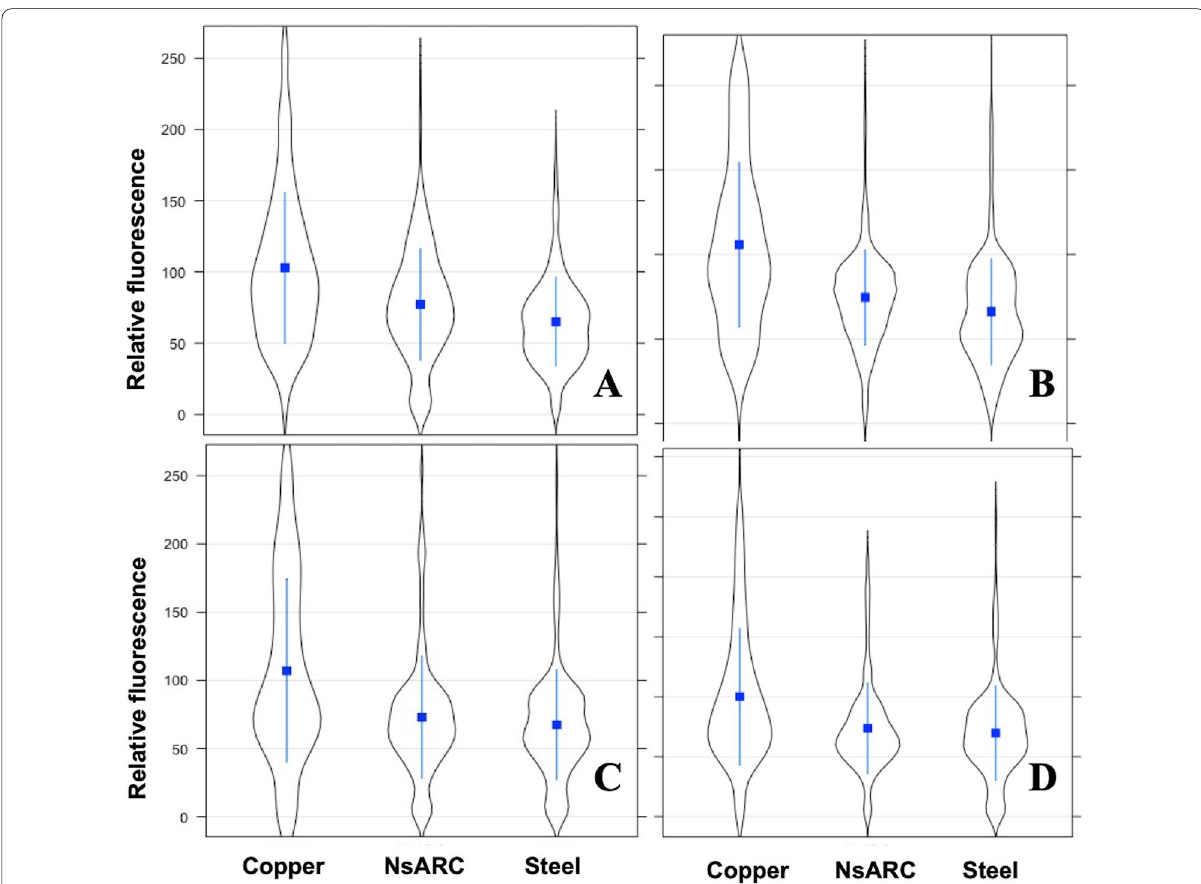
Fig. 4 Single-cell fluorescence intensity of E. coli BW25113 expressing mScarlet red fluorescent protein under the control of the tolC promoter upon exposure to copper, NsARC and stainless steel under ( A ) UV light, ( B ) visible light, ( C ) ambient light and ( D ) dark. The violin plots show the distribution of the single-cell fluorescence within the cell population. The bar in the box depicts the median and the box shows the 25% and 75%